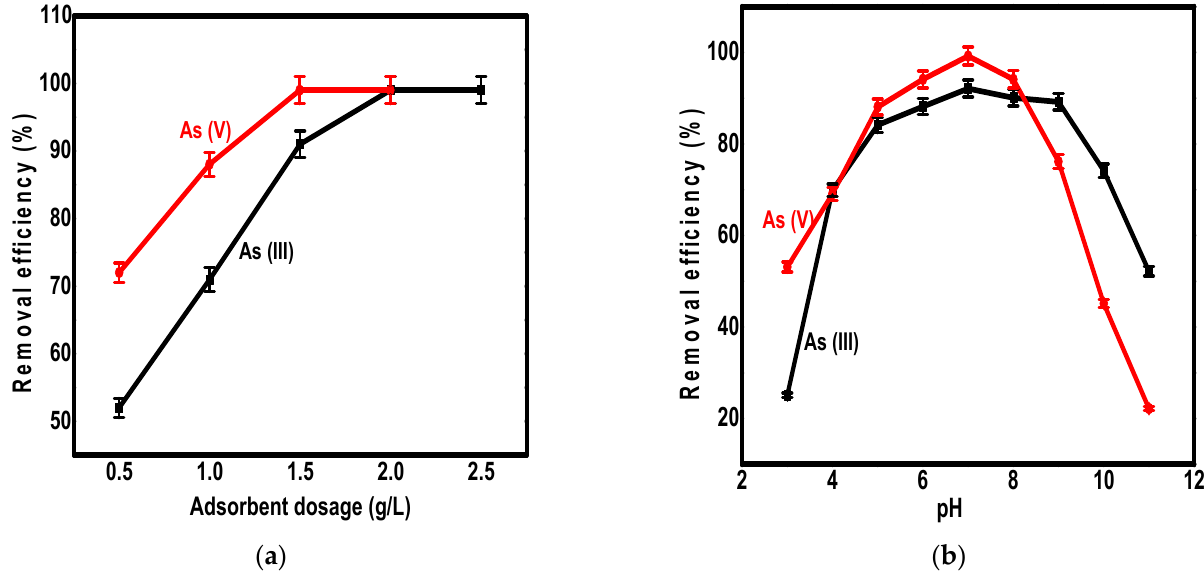
Figure 5. The adsorbent dosage effect ( a ) and pH value effect ( b ) on the adsorption of As(III) and As(V) ions over the surface of Fe 3 O 4 /CS/PEI nanocomposite.